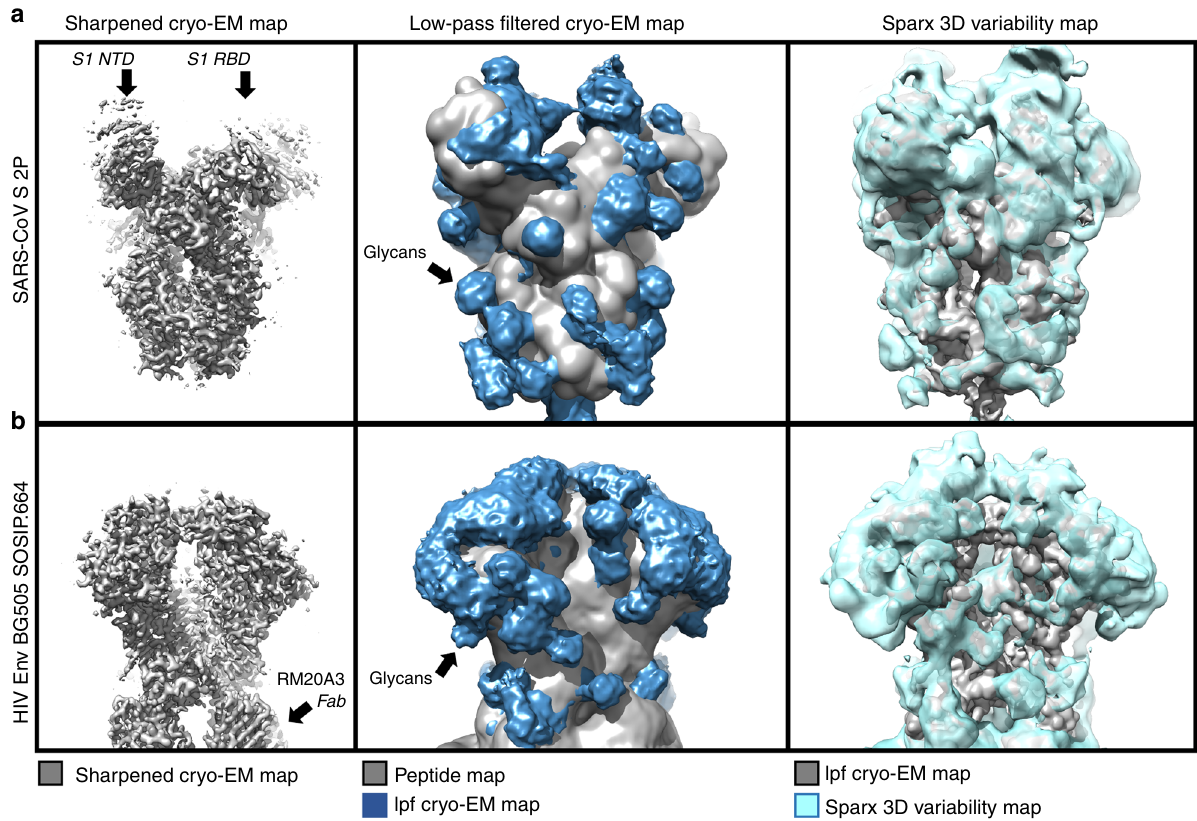
Fig. 5 Comparative cryo-EM analysis of SARS S and HIV-1 Env glycan shields. a Left panel: Sharpened 3.2- Å -resolution C3-symmetric cryo-EM map of SARS S 2P ectodomain 52 visualized at a high contour level with disordered S1 receptor-binding and N-terminal domains extending out from the central core. Middle panel: Low-pass fi ltered (lpf) cryo-EM map of the glycoprotein visualised at a low contour level along with a simulated peptide-only map overlaid. Right panel: SPARX 3D variability map 51 . b Same as in ( a ) but for HIV-1 Env BG505 SOSIP.664 construct in complex with three copies of RM20A3 base-speci fi c Fabs 51